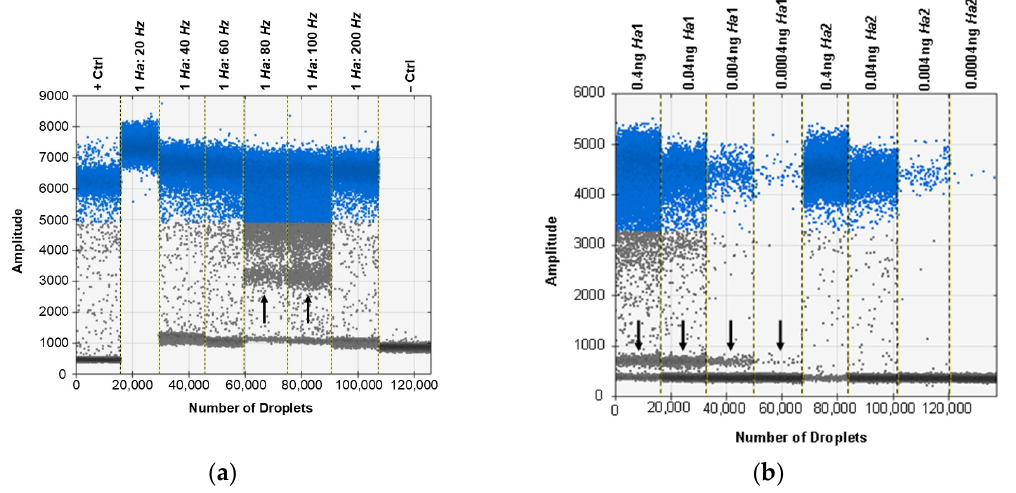
Figure 3. When the probe is used for ddPCR, an alternate cluster of droplets is evident for some samples. ( a ) The cluster (indicated by the black arrow) is prominent between the positive (blue) and negative (grey) droplets in lanes labeled 1 Ha : 80 Hz and 1 Ha : 100 Hz . ( b ) The cluster (indicated by the black arrow) is still evident after assay optimization and use of a touchdown thermocycling program. It is evident in the lanes labeled 0.4 ng Ha 1 and 0.04 ng Ha 1.